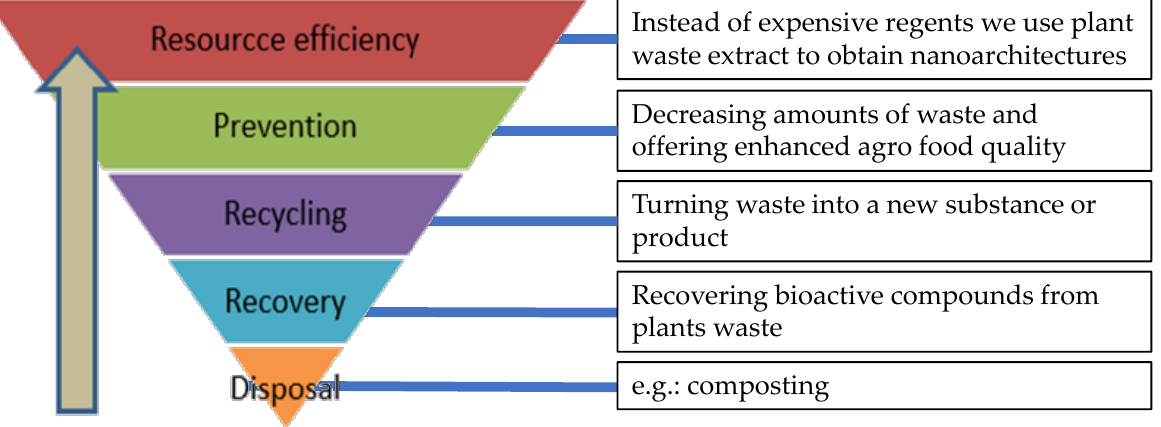
Figure 2. Current bioeconomy approaches of the cruciferous vegetables waste in nanocoating. Hayek and Schultz [6,7] were the first researchers who published information about the origin of Brassicaceae. Brassica is a genus of plants in the Brassicaceae family (the cabbage and mustard family). The members of the Brassica genus are known as cruciferous vegetables and Brassica spp. (Table 1) is generally classified into three groups: mustards, coles, and rapeseeds [8]. The name comes from the shape of the flowers that are in the shape of a cross. They have been cultivated for centuries, mainly in Europe and Asia, and there are several varieties that belong to this large family of